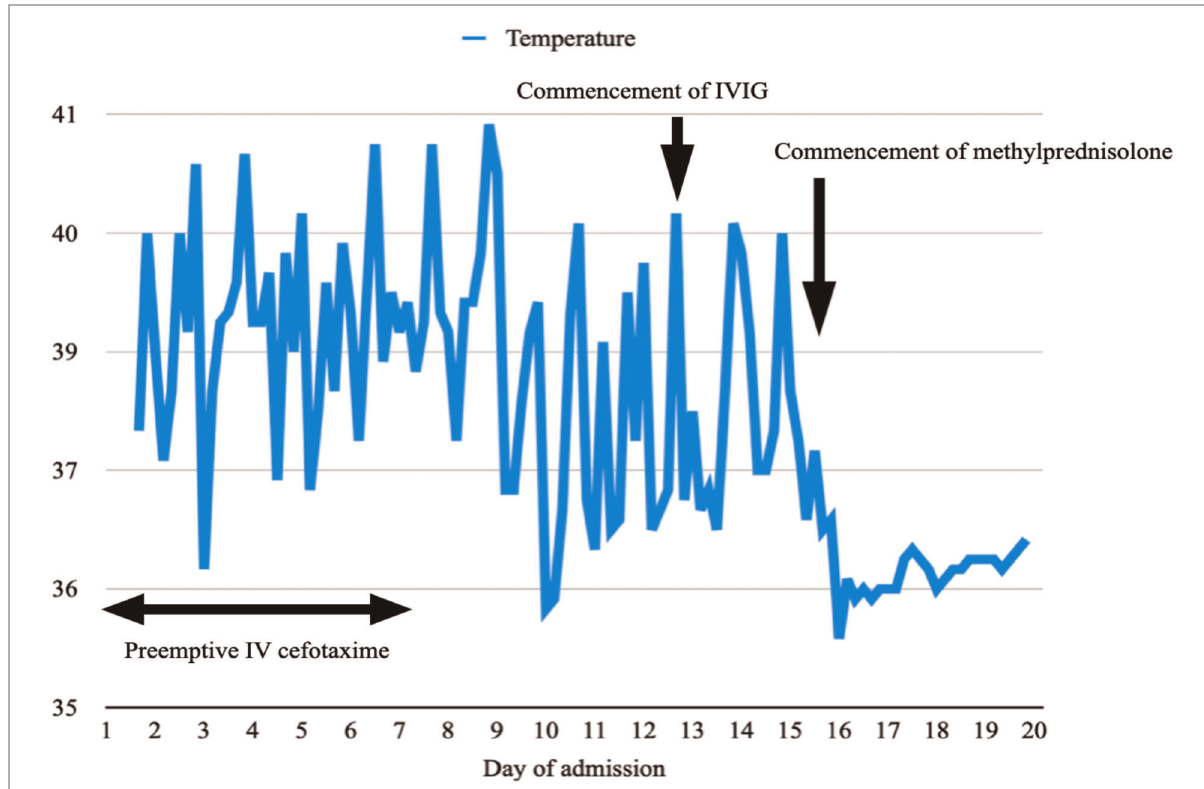
FIGURE 3 A temperature graph illustrating a remittent and intermittent fever, which persists despite a course of IV cefotaxime from day 1 to 7 of admission and IVIG on days 13 and 14. The fever settles promptly after the commencement of IV methylprednisolone on day 15 and does not